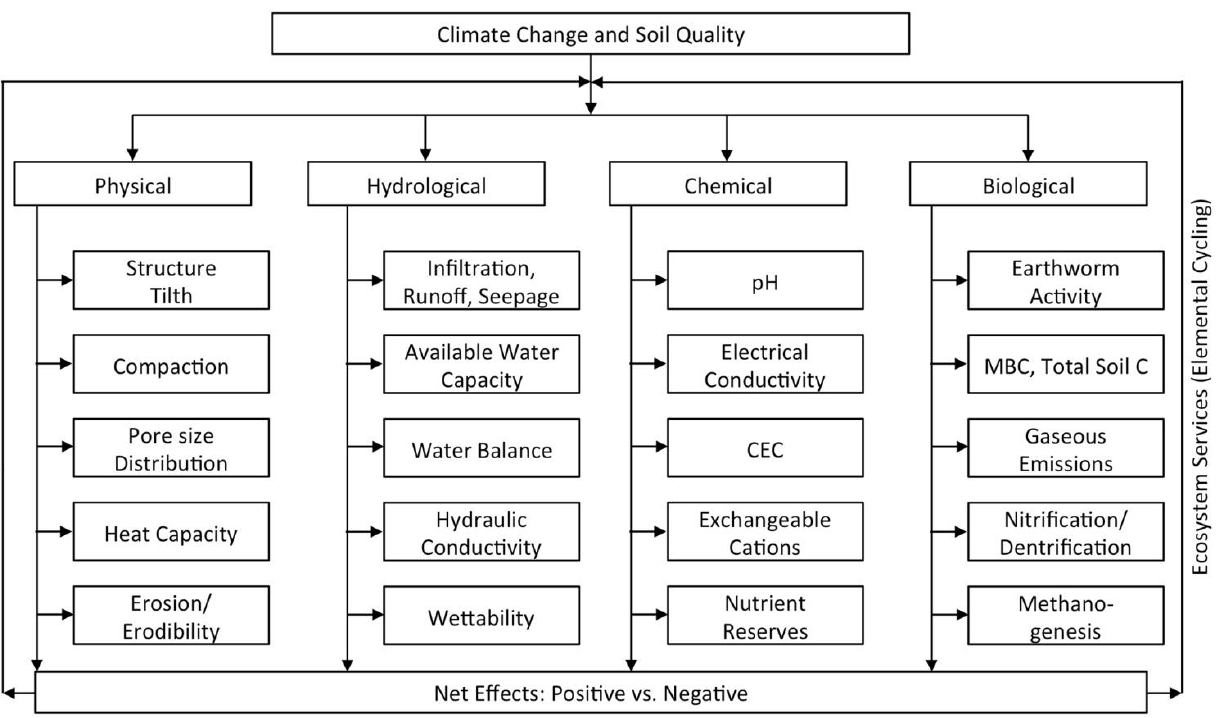
Figure 2. The effects of climate change on alterations (negative or positive) in soil properties and